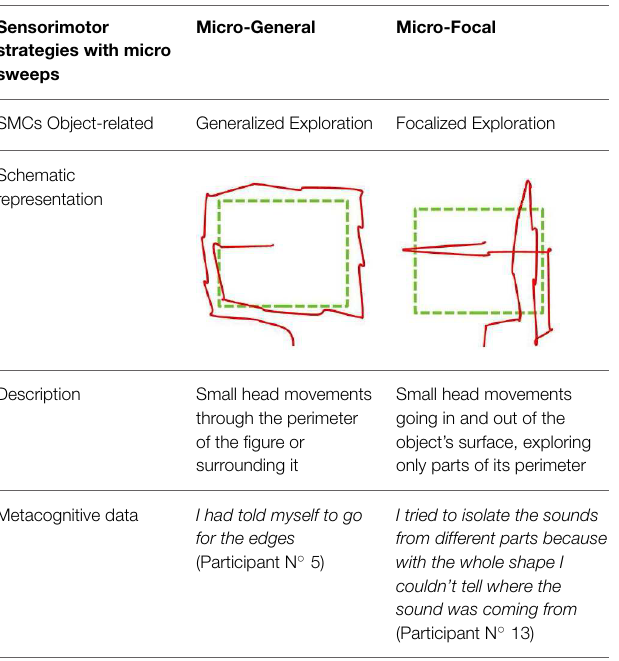
TABLE 4 | Sensorimotor strategies components of that used Micro-Sweep.